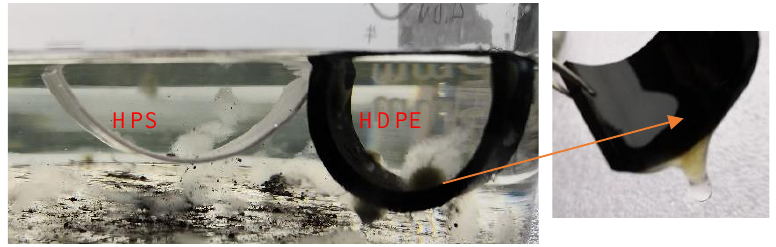
Figure 11. Material samples immersed in the simulated leachate (pH = 4.0).